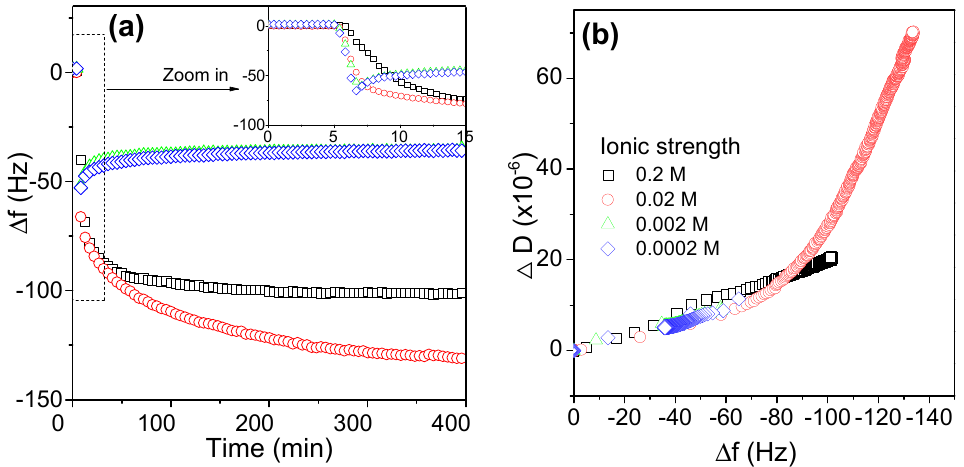
Figure 5. Effects of ionic strength on the adsorption amount ( a ) and the conformation ( b ) of the AmPAM adlayer. The tested AmPAM sample was of MW of 336 k and the polymer concentration was 100 mg/L.